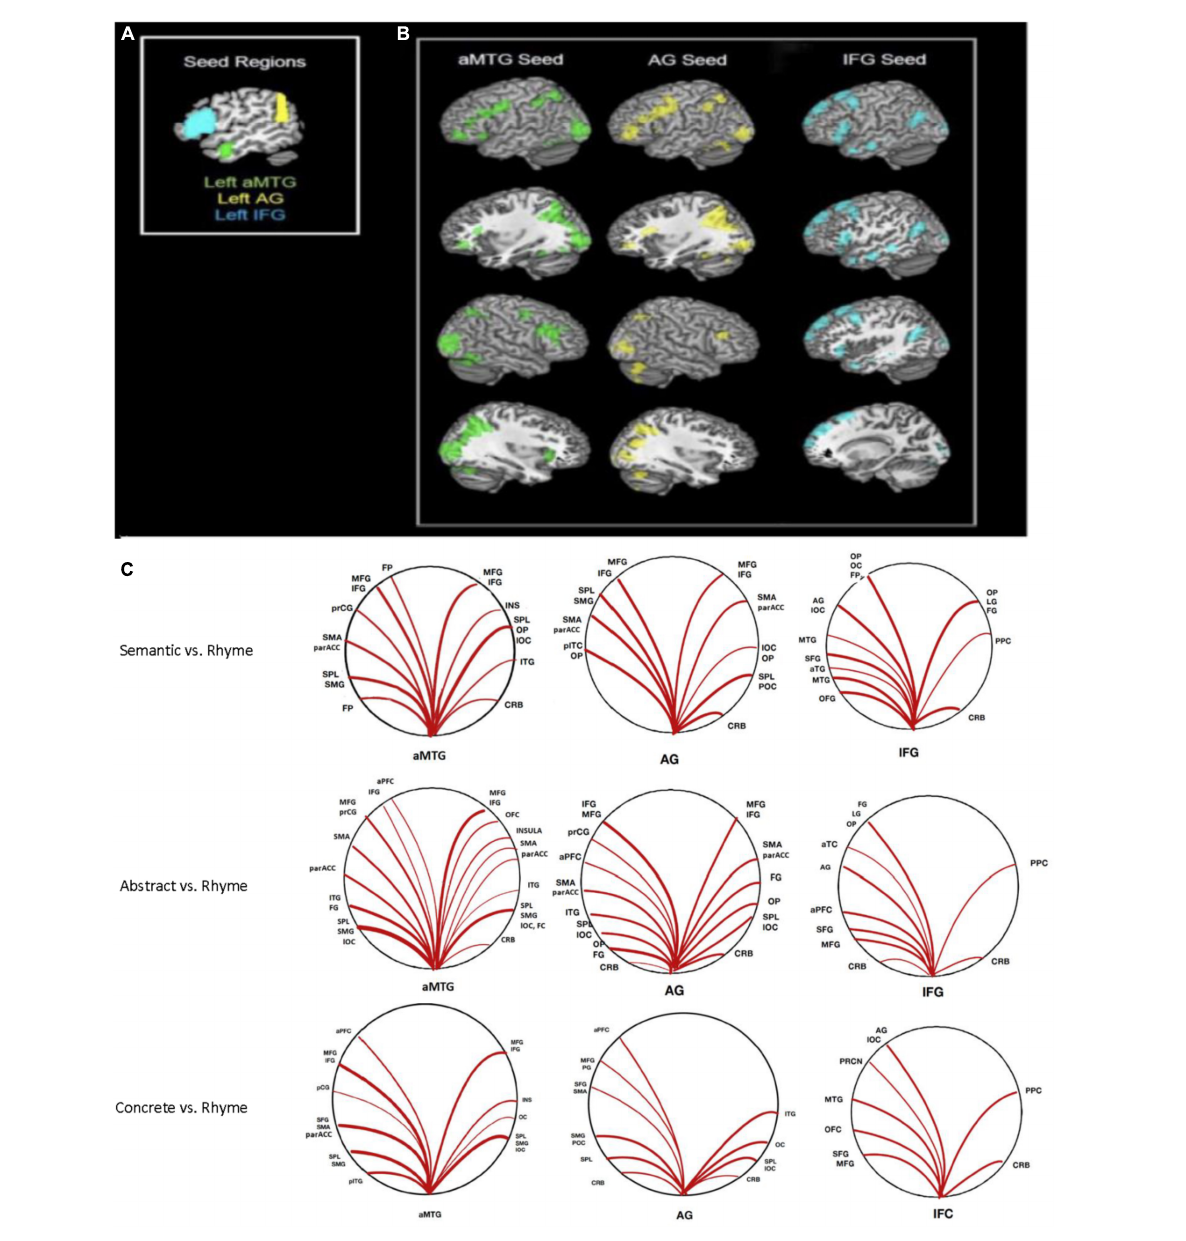
FIGURE2 Seed-to-voxel connectivity: (A) Seeds in anterior middle temporal gyrus (aMTG), angular gyrus (AG), and inferior frontal gyrus (IFG). (B) Regions with significant connectivity with each seed during semantic processing (abstract + concrete combined). (C) Graphic representation of significant connections ( p < 0.05, FWE corrected) to each seed for contrasts of overall, abstract, and concrete semantic relative to the rhyme